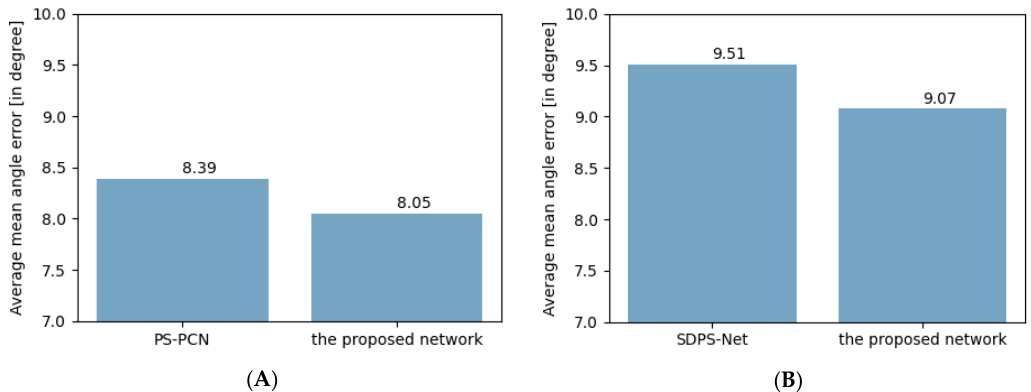
Figure 3. The accuracy comparison ours with baseline models: ( A ) calibrated photometric stereo evaluation; ( B ) uncalibrated photometric stereo evaluation